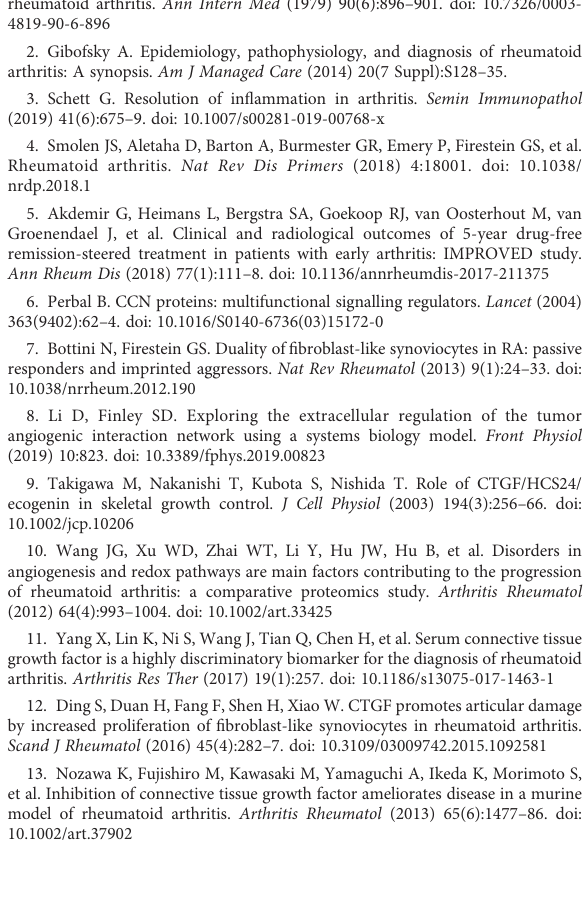
SUPPLEMENTARY FIGURE S1 Top 100 sequences from the fi nal aptamer products based on HTS analysis.